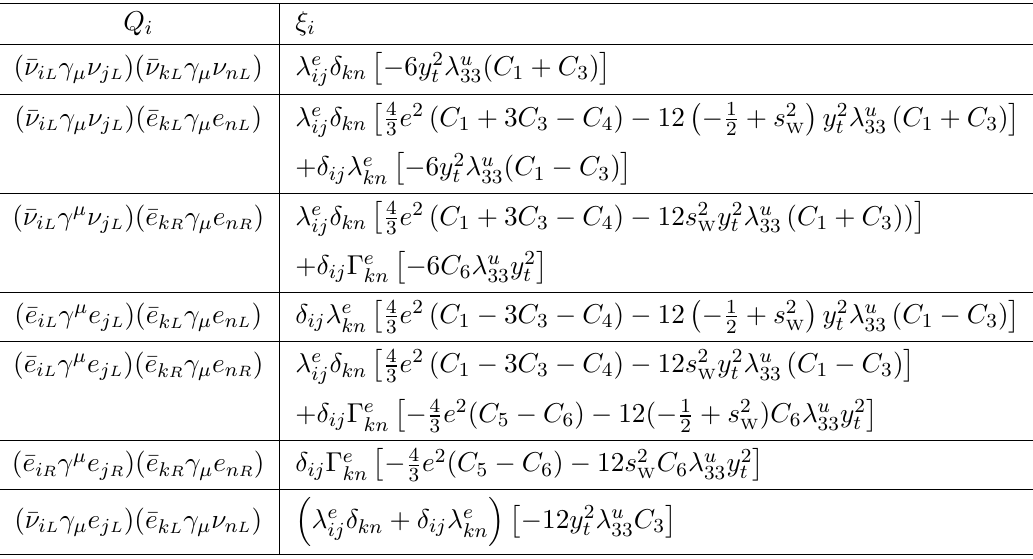
Table 2 . Operators Q i and coe(cid:14)cients (cid:24) i for the purely leptonic part of the e(cid:11)ective Lagrangian L EW . We set sin 2 (cid:18) W (cid:17) s 2 e(cid:11) W